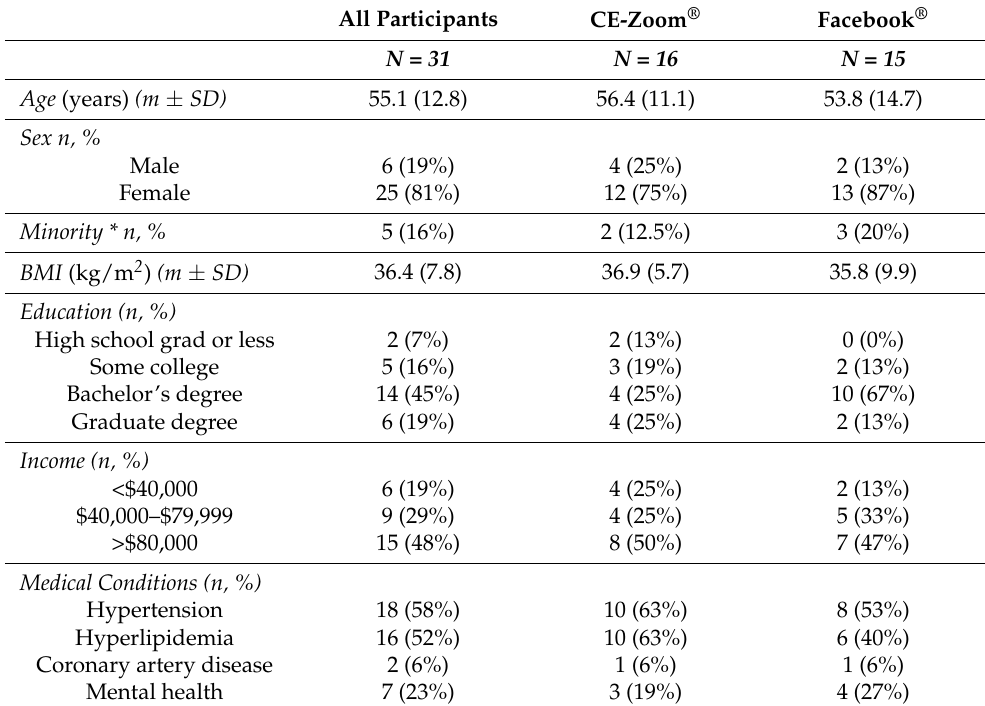
Figure 2. Consort Diagram. Table 1. Baseline participant characteristics.